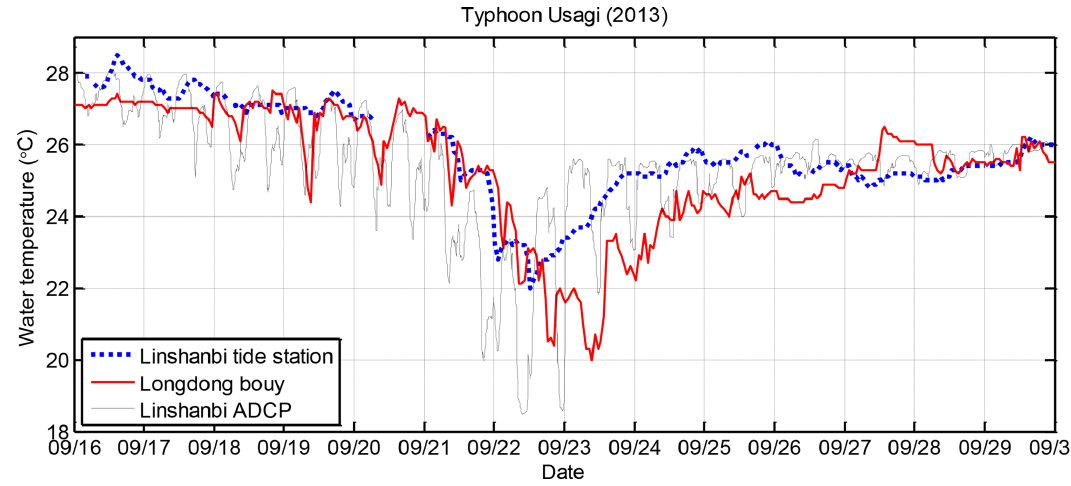
Figure 2. SST drop observed by various types of instruments during Typhoon Usagi in